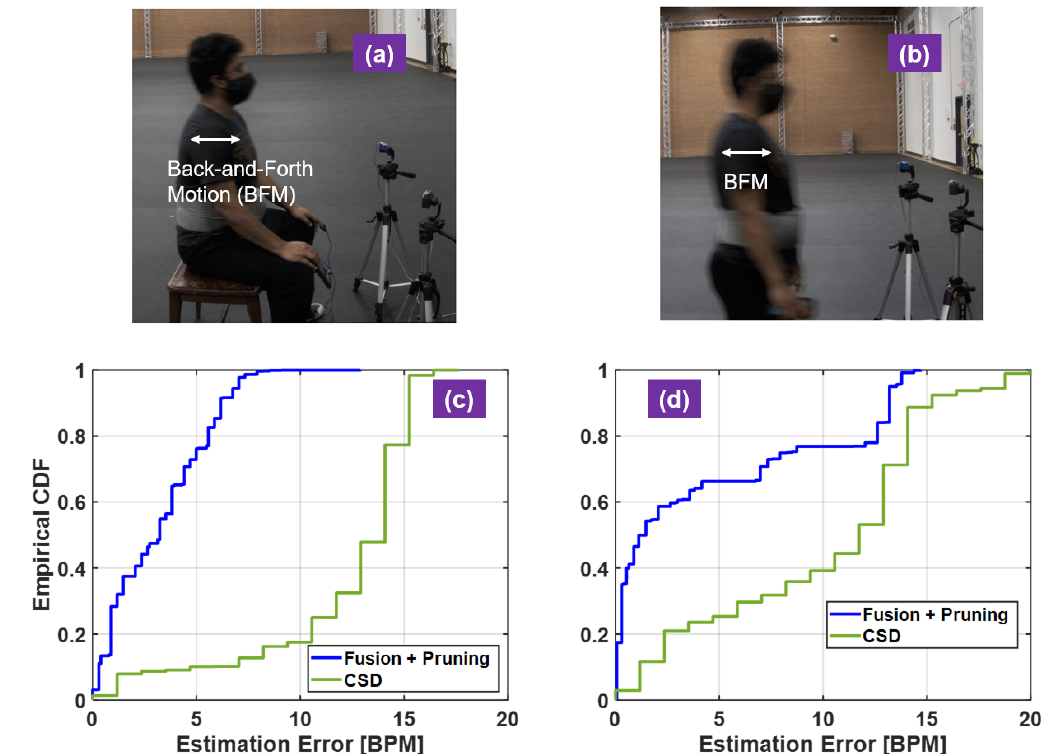
Figure 7. HR estimation error analysis for free-style seating and standing with back-and-forth motions (BFM). ( a ) experiment scene of free-style seating with BFM; ( b ) experiment scene of standing with BFM; ( c ) estimation CDF of free-style seating with BFM; ( d ) HR estimation error CDF of standing with